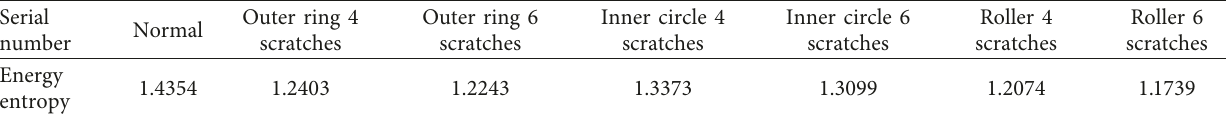
Table 4: The energy entropy value distribution of the first category failure mode (inner ring, outer ring, and roller). Serial